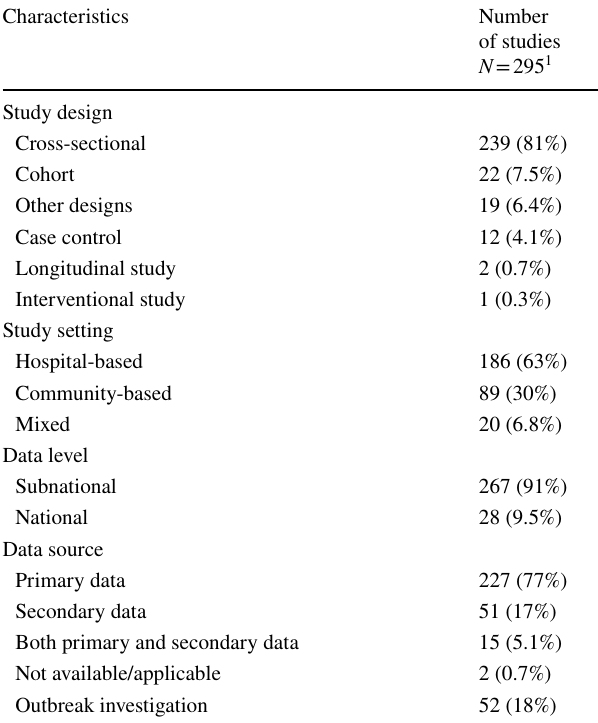
Table 1 Study characteristics—review of vector-borne and zoonotic diseases in the Eastern Mediterranean region